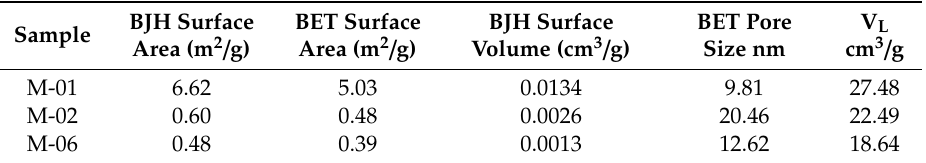
Table 2. Results of Low-temperature N 2 adsorption / desorption